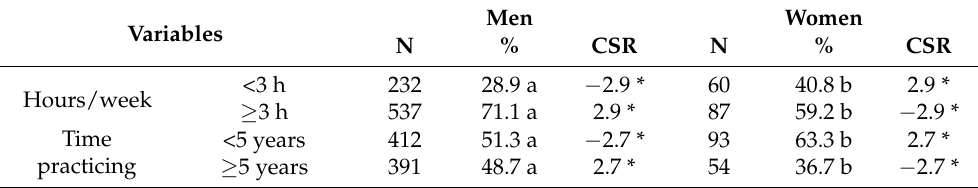
Table 3. Differences in the experience and volume of habitual padel practice between men and women.